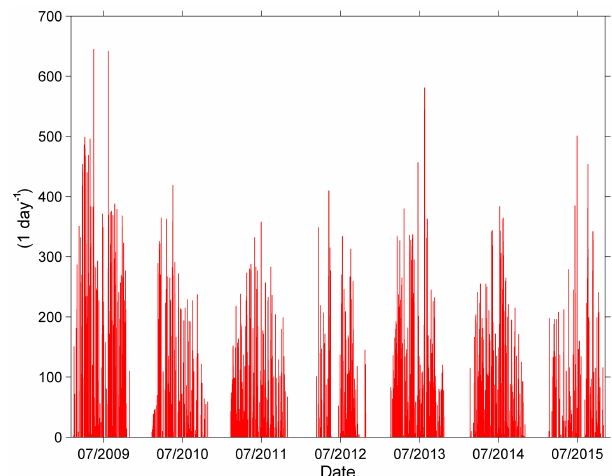
Figure 4. Distribution of FTS measurements per day at Sodankylä during 2009–2015. Criteria for an accepted measurement shown here is solar zenith angle <82 ◦ and solar intensity variation <5%. In total, 123715 spectra were recorded during the 7-year period, corresponding to 1022 measurement